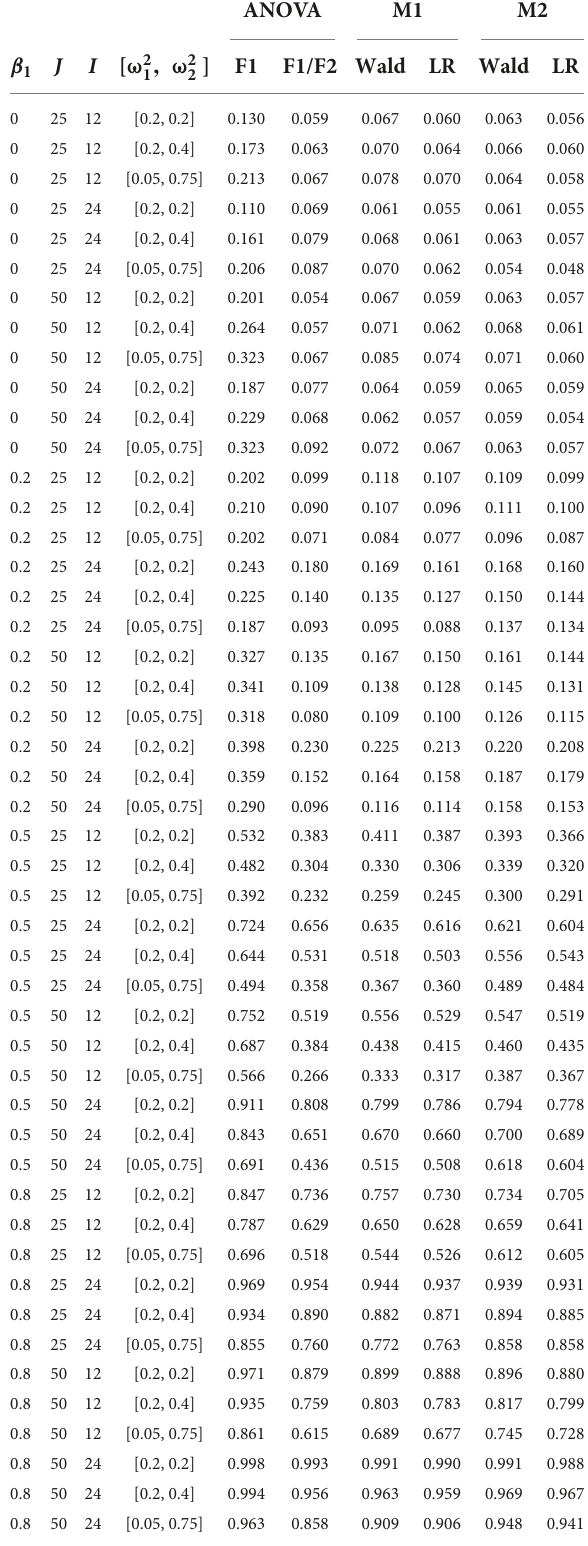
M1, common item random effect model; M2, level-specific item random effect model; β 1 , magnitude of experimental condition; J, number of participants; I, number of items; [ ω 2 1 , ω 2 2